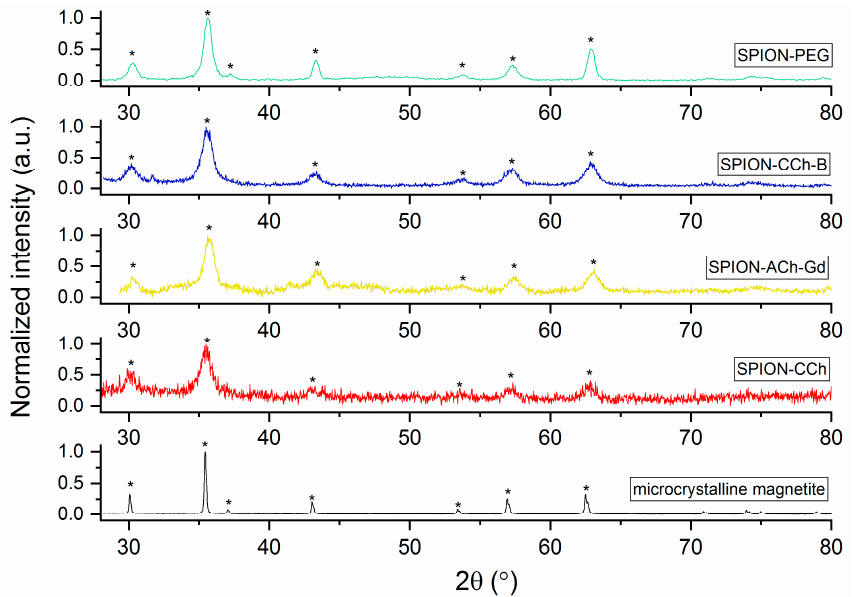
Figure 2. XRD patterns of microcrystalline magnetite, SPION-CCh, SPION-ACh-Gd, SPION-CCh-B and